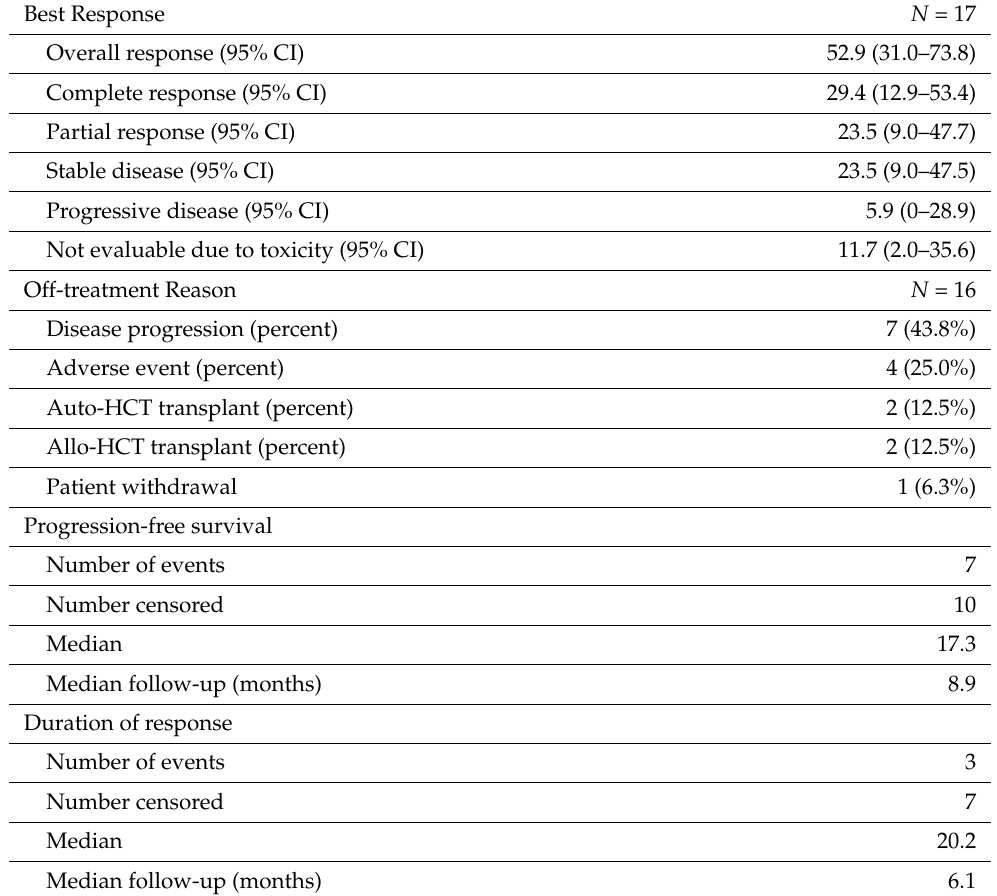
Table 2. Response and Outcomes.